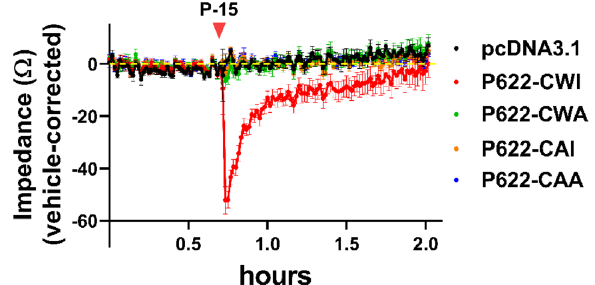
Figure 8. Whole-cell impedance assay shows a lack of activation of the ECL2-mutated ADGRG2 receptor by the Stachel peptide. Cells were transfected with adjusted doses of WT and mutant plasmids and were then seeded in plates that have electrodes at the bottom of each well to apply various frequencies of electric voltages. Serum-starved cells, at monolayer confluency, were kept in Maestro Z device until the recorded impedance (Ω) reached a steady state. Cells were stimulated with either vehicle (DMSO) or 100 µM P-15 and impedance was recorded for up to 2 h. Data are corrected to that of the vehicle for each plasmid and are mean ± S.E.M from a representative experiment out of 3 independent experiments conducted in